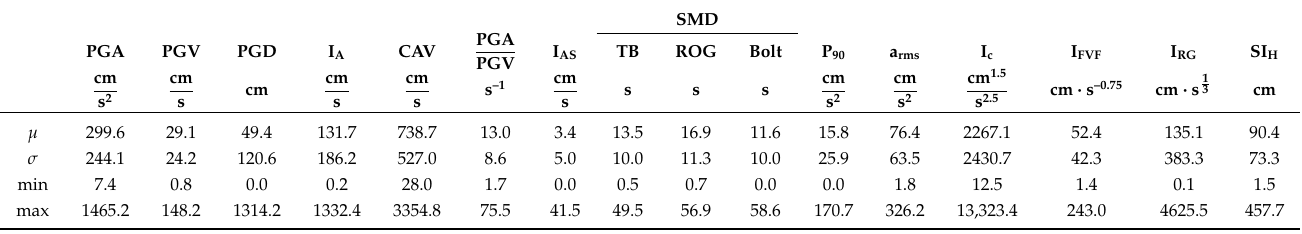
Table 2. Descriptive statistics for the IMs of the overall dataset.